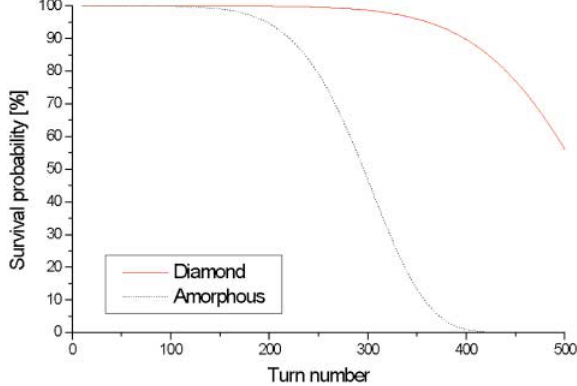
FIG. 7. (Color) The survival probability, Eq. (15), as a function of the number of turns in the machine. The solid line is for a diamond, while the dotted line is for an amorphous carbon target, both of 240 m g (cid:2) cm 2 .